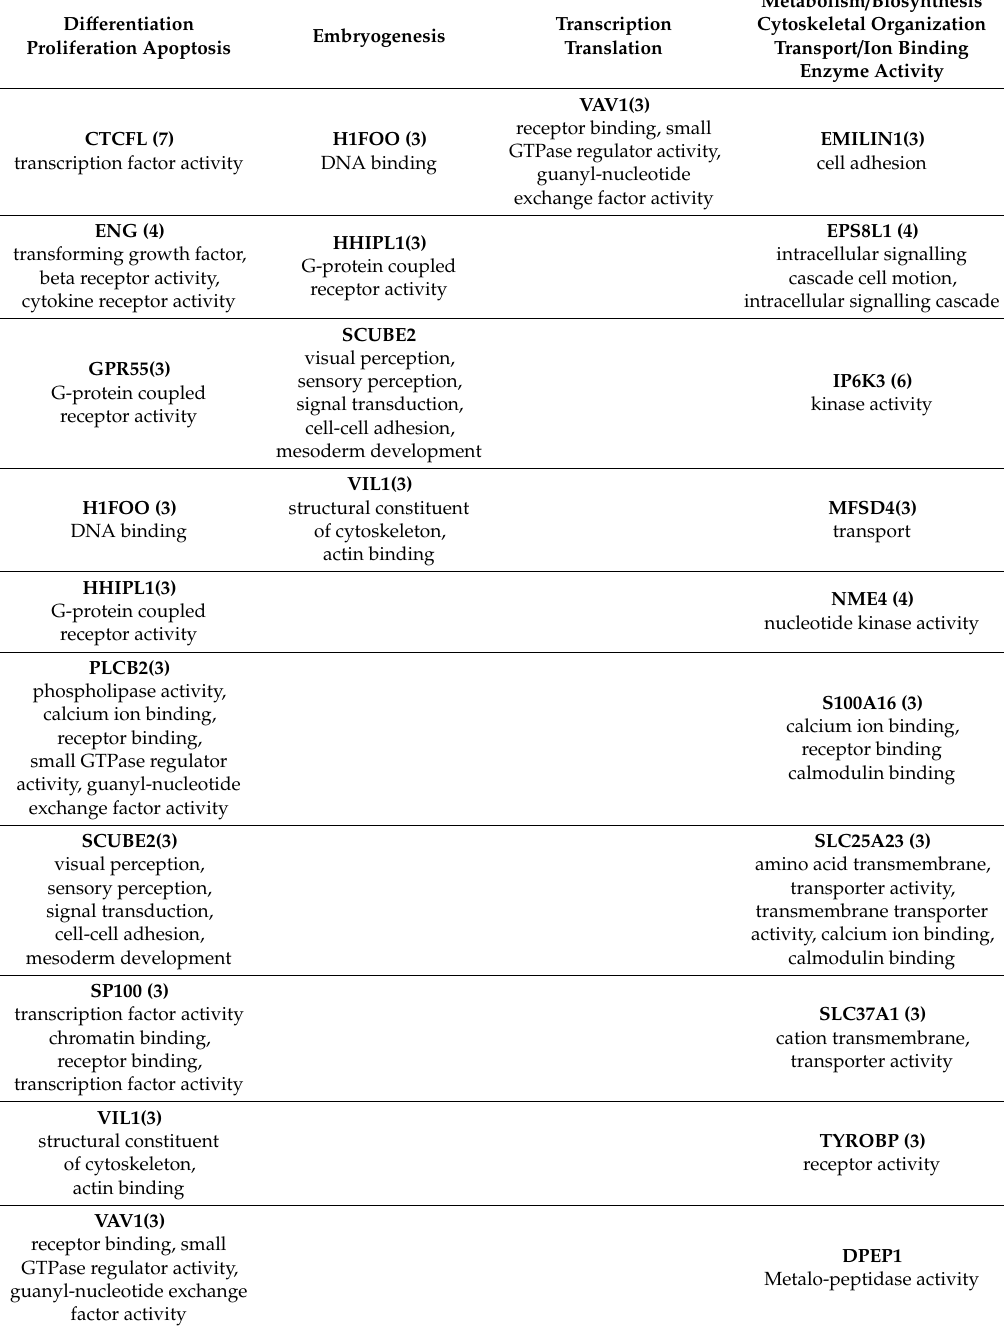
Table3. Functional classificationof iM-forming geneswith threeor more5hmCs within aG4 / iM-forming sequence downstream of the TSS. The number of 5hmCs present is given in